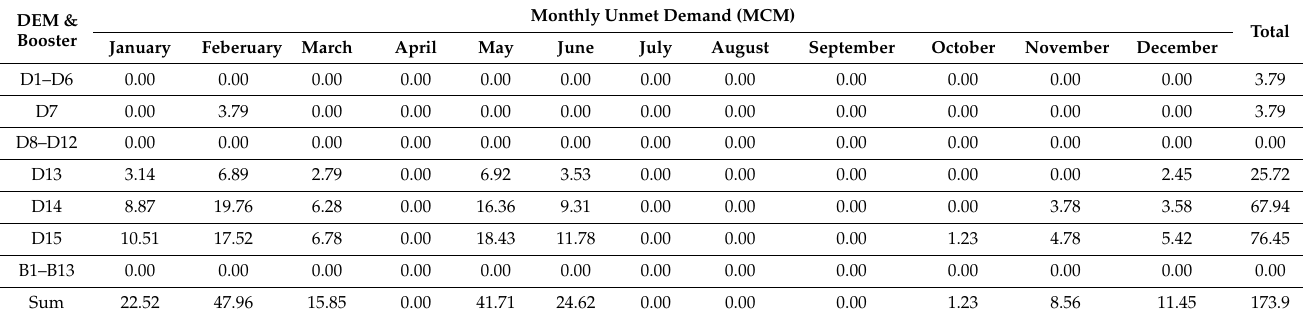
Table 12. Monthly unmet demands (MCM) of lining four sections.